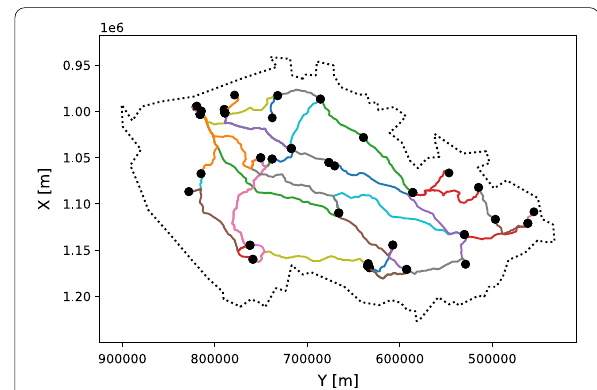
Fig. 1 The map of the 400-kV Czech transmission network. The dotted line represents the simplified borders of the Czech Republic. Individual transmission lines are plotted with different colours. The units on both axes represent the S-JTSK coordinates. The black points indicate the location of the